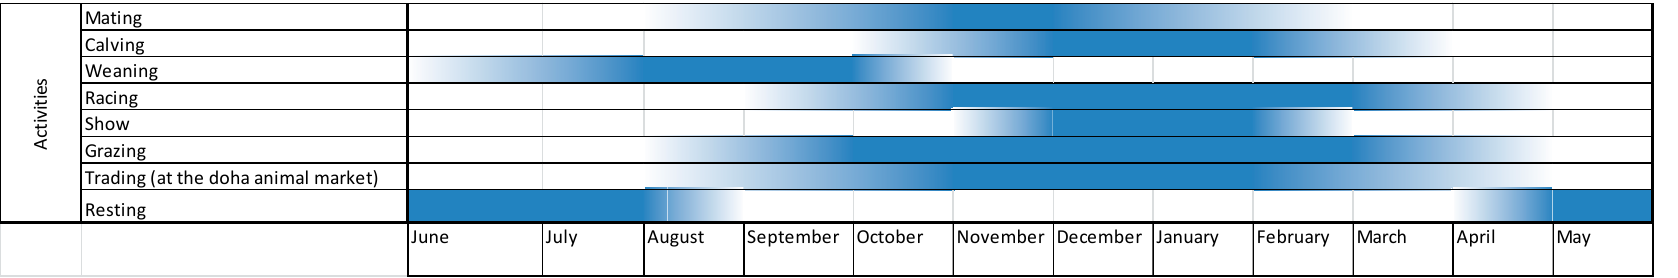
Figure 4. Seasonality and movements of camels and camel activities. ( A ) Dark green locations and periods of time indicate a high concentration of camels. The arrows show the direction of camel movements. It is shown that many camels gather and mix at the animal market, racing track, and breeding farms in Qatar in August, September and October. Moreover, there is constant movement to and from grazing grounds and racing tracks outside of Qatar. In March and April, most camels travel back to their barns. ( B ) shows the seasonality of camel related activities. Most activities take place in the “cold season” from September to